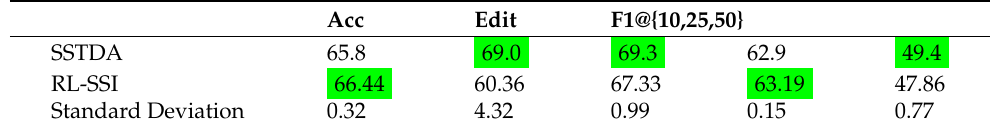
Table 16. Comparison of SSTDA [16] and